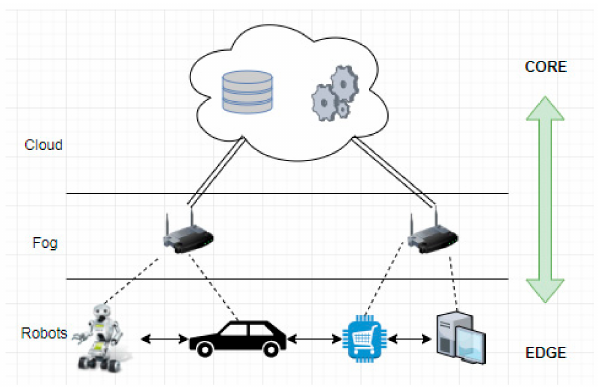
Figure 1. Overall Cloud-Fog-Edge